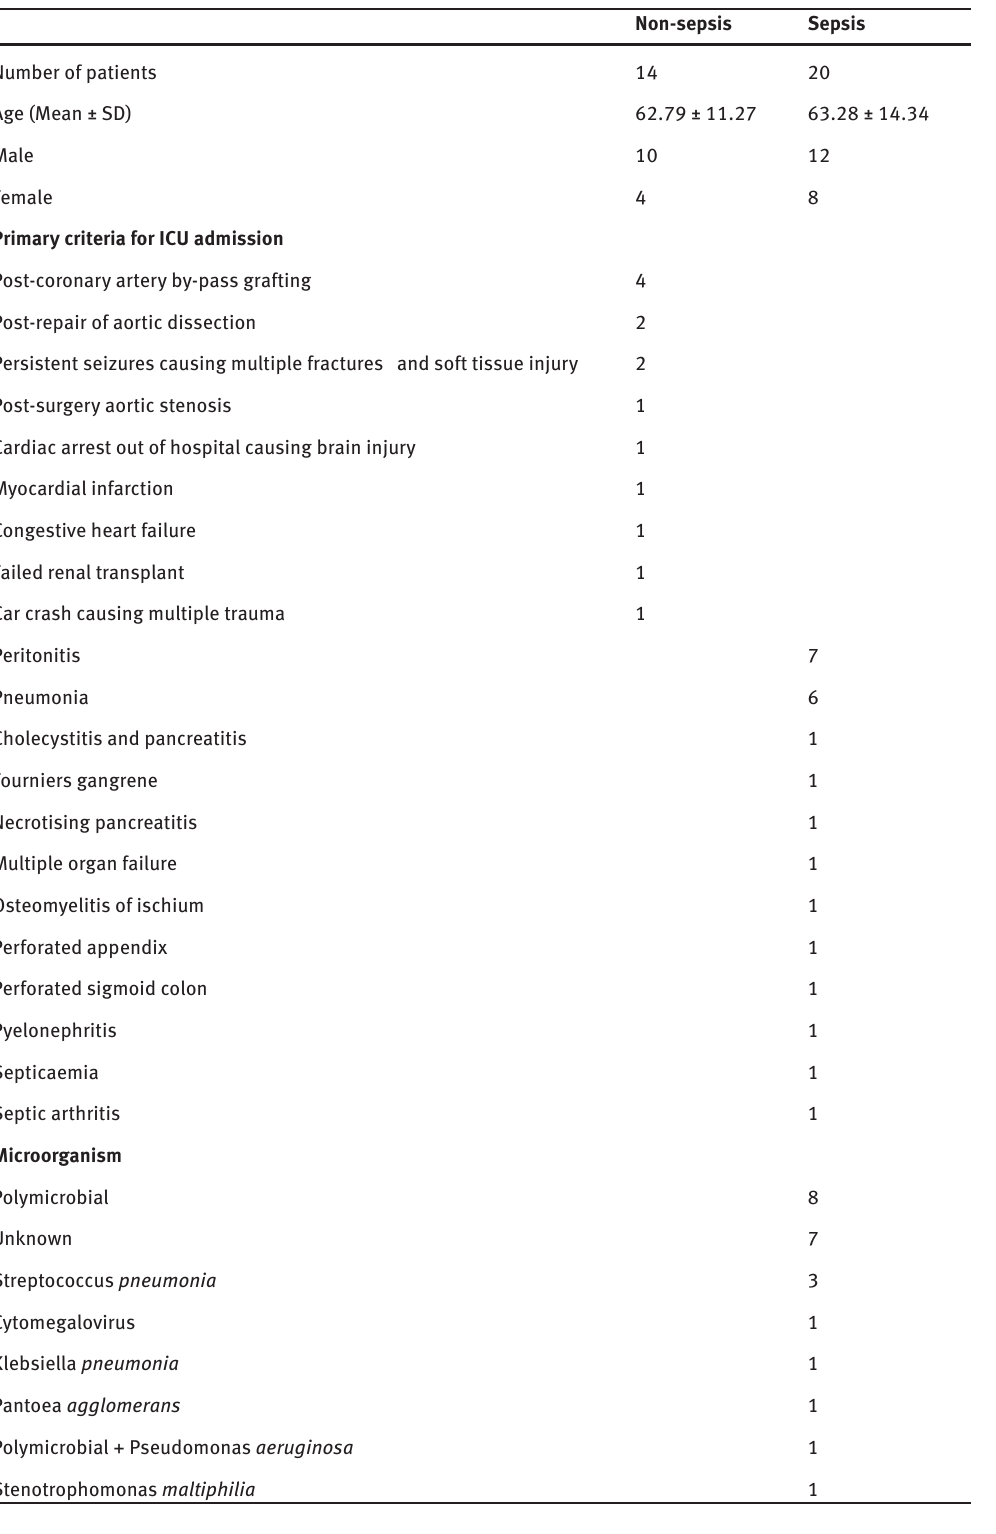
Table 2 : Characteristics of sepsis and non-sepsis patients admitted to the medical intensive care unit during the 2015-16 study period. Some sepsis patients had more than one condition or microorganism